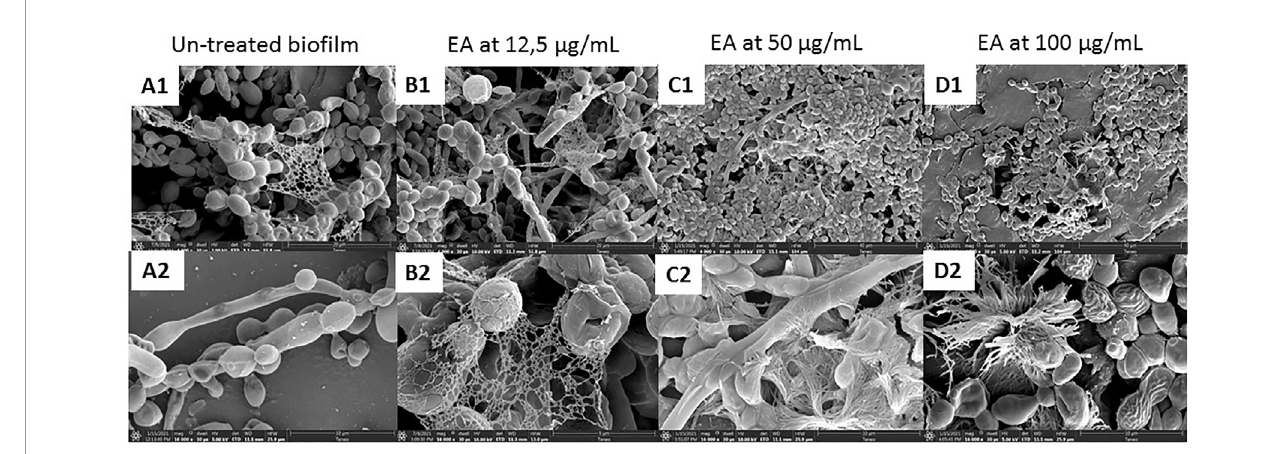
FIGURE 2 | Candida albicans bio fi lm observed by scanning electron microscopy. C. albicans bio fi lm without evernic acid ( A , 1, 2). C. albicans bio fi lm treated with 12.5 µg/ml ( B , 1, 2), 50 µg/ml ( C , 1, 2), and 100 µg/ml ( D , 1, 2) evernic acid. ( A — 1, B — 1, C — 1, D — 1: magni fi cation, ×4,000; A — 2, B — 2, C — 2, D — 2: magni fi cation,